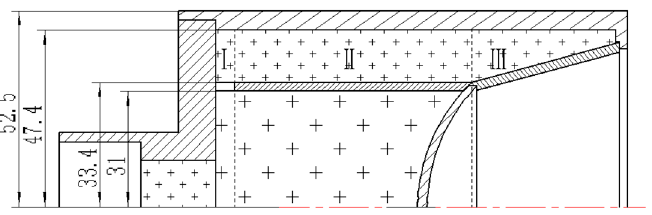
Figure 2. Schematic of the explosive pressure-coupling constraint principle. I—Impact initiation area; II—constraint area; III—ejection area.